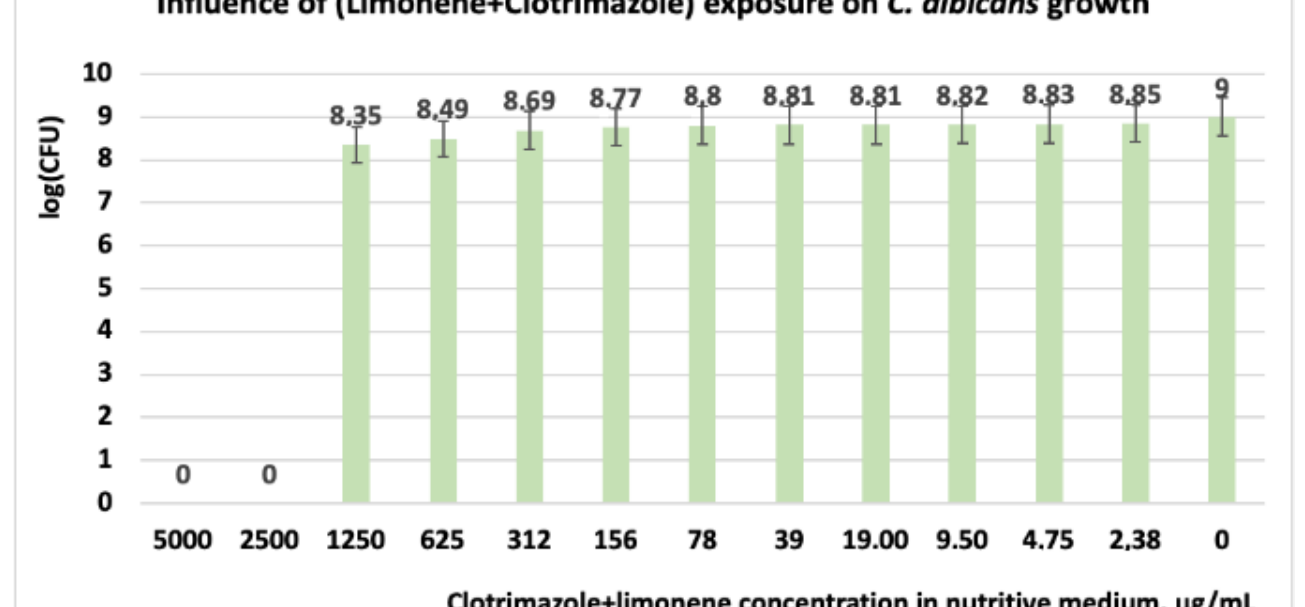
Figure 7. Influence of (CT + limonene) exposure on C. albicans growth, after 48 h. At a concentration of limonene + clotrimazole in the culture medium higher than 1250 μg/mL, C. albicans is